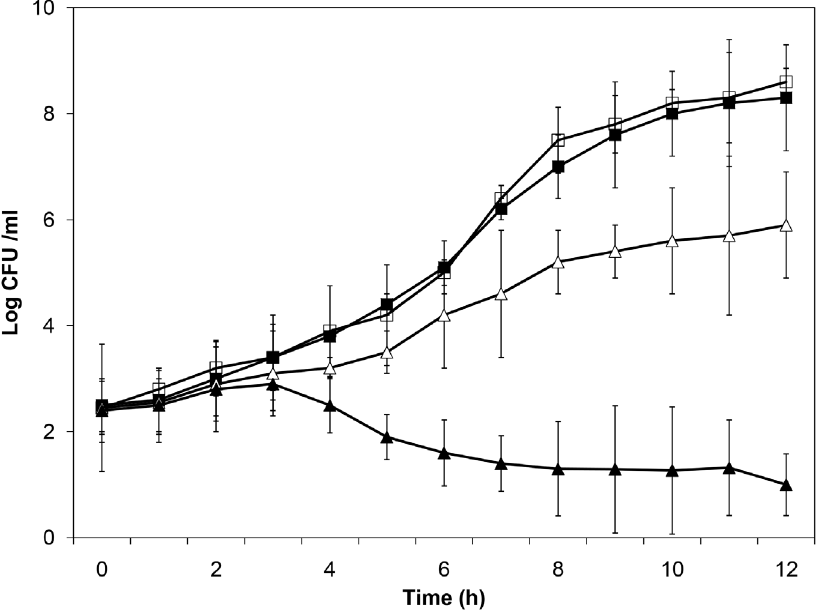
Figure 2. Effect of lactoferrin concentrations on ETEC H10407 growth with and without an excess of ferric chloride. Bacteria were incubated on Luria Broth (control) ( & ) or bovine lactoferrin at 1.0 mg/mL ( D ) or 10.0 mg/mL ( m ) or bovine lactoferrin at 10 mg/mL with an excess of ferric chloride ( % ) (4:1 molar ratio of iron to lactoferrin) for 12 h. Three dilutions of the bacterial culture were plated on agar to determine the number of colonization forming units (CFU) (mean 6 SD of 3 experiments).